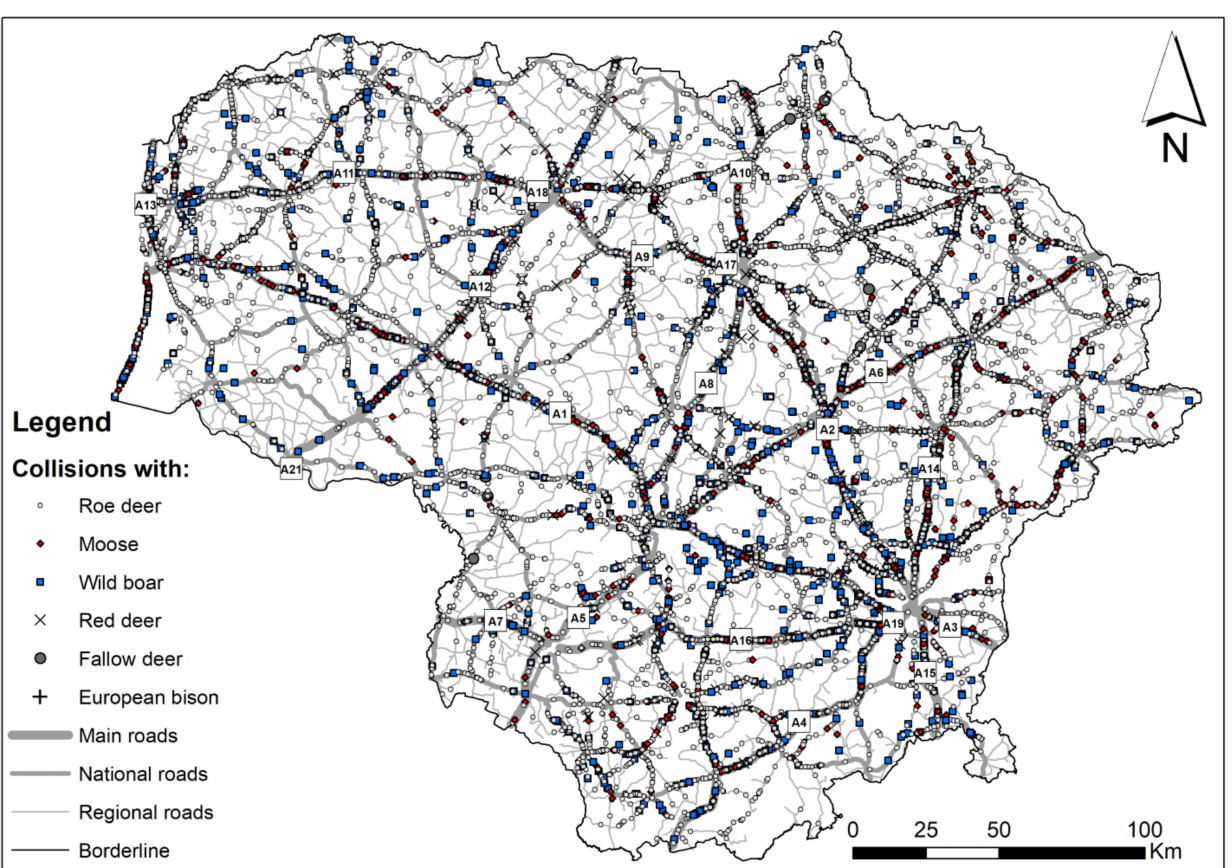
Figure 2. Locations of the ungulate–vehicle collisions (UVCs) in Lithuania,